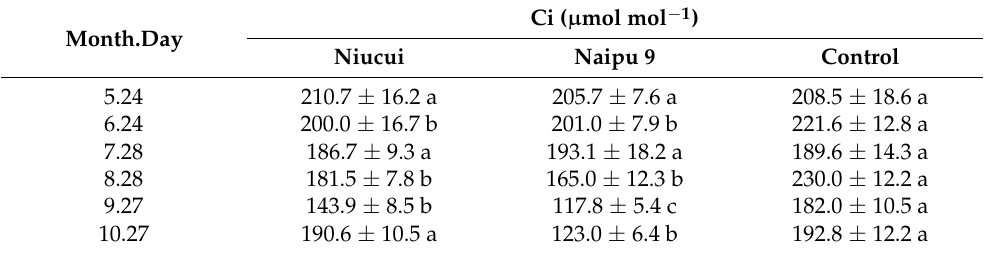
Table 9. Effects of spraying calcium fertilizer on intercellular CO 2 concentration (Ci) of apple leaves.